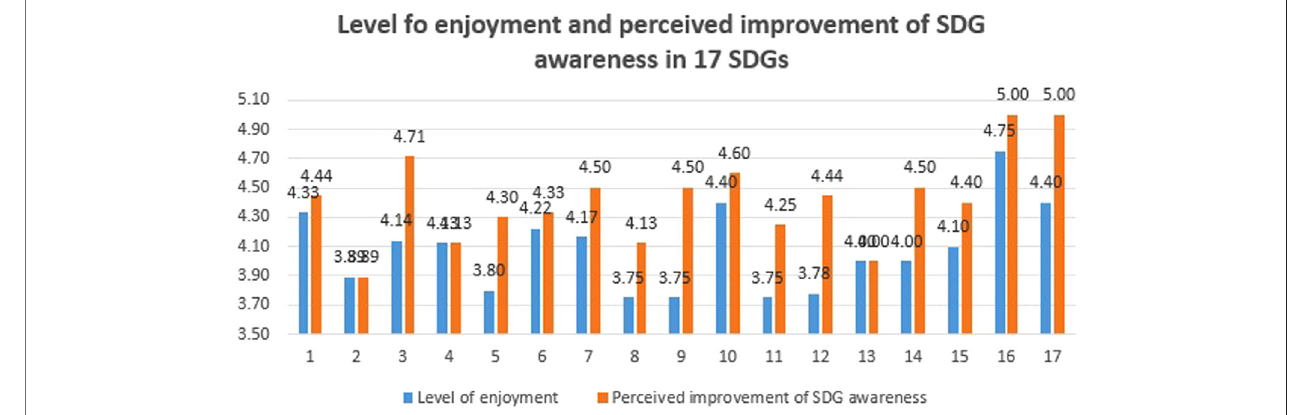
FIGURE 4 | Level of enjoyment and perceived improvement of SDG awareness in 17 SDGs.